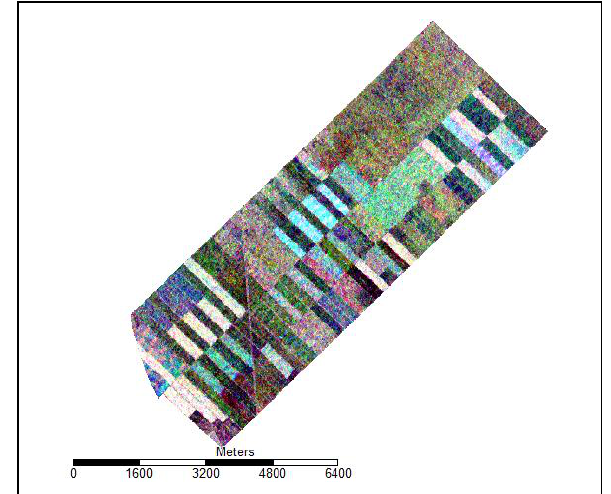
Figure 2. RGB composite of Sentinel-1 (R: 20160613,